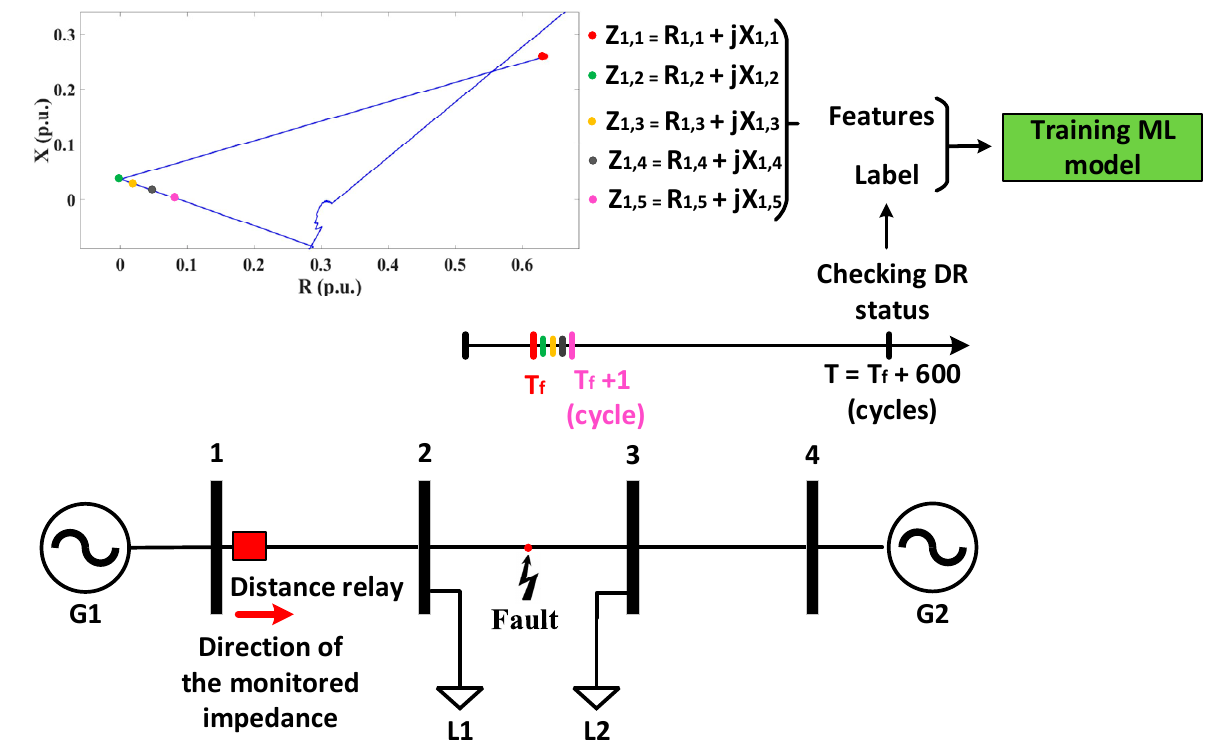
Figure 2. Conceptual representation of the process of extracting the features and labels for training an ML model.